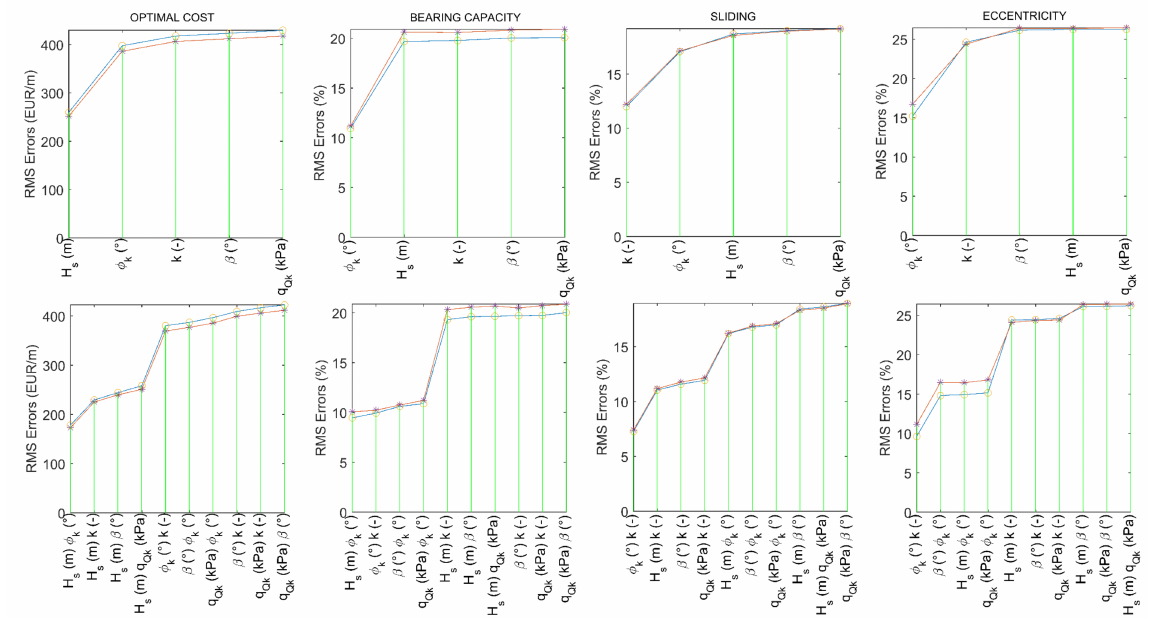
Figure 12. Influence of each input variable on the optimal cost of a gravity retaining wall and the utilization of geotechni- cal